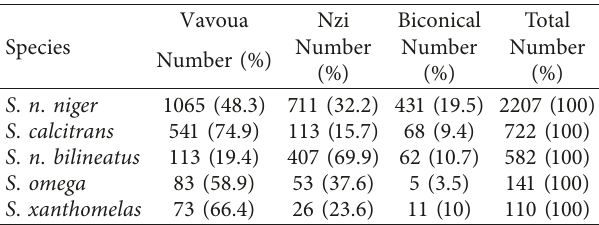
Table 2: The number and proportion of Stomoxys spp. with respect to trap type.